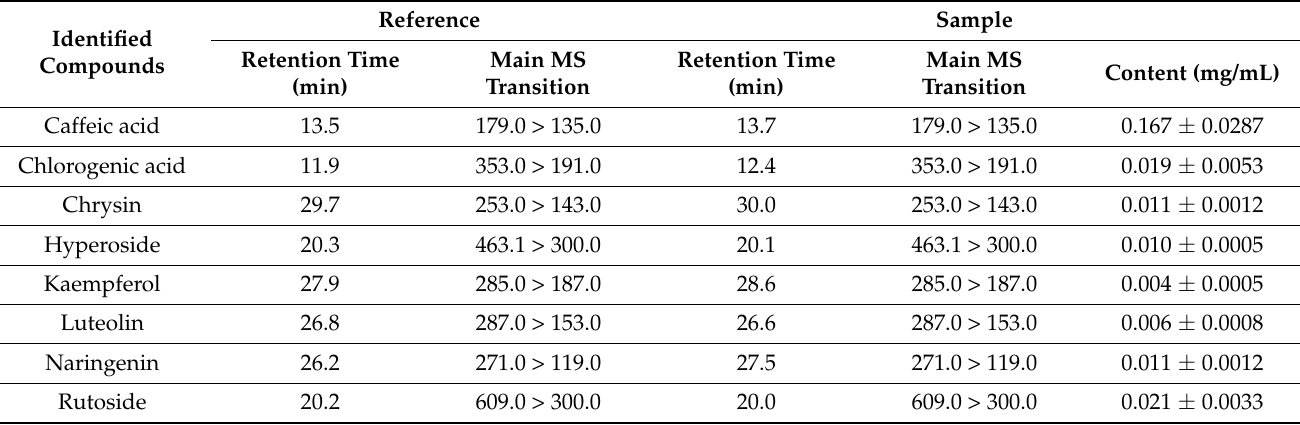
Table 1. LC/MS identification and quantification of polyphenols from the tested Cornus mas L.